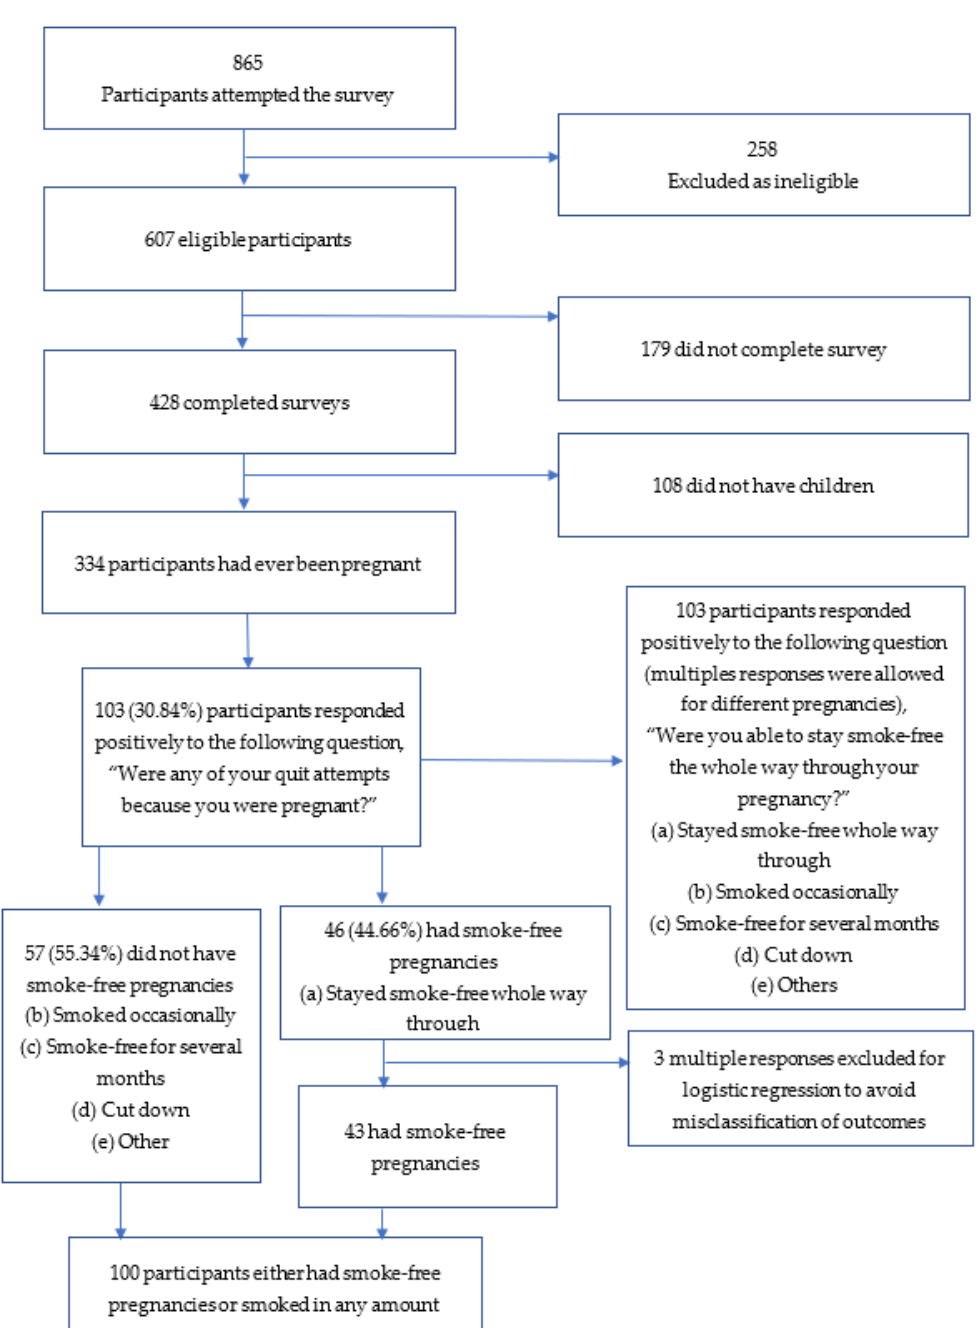
Figure 1. Diagram showing recruitment of participants.